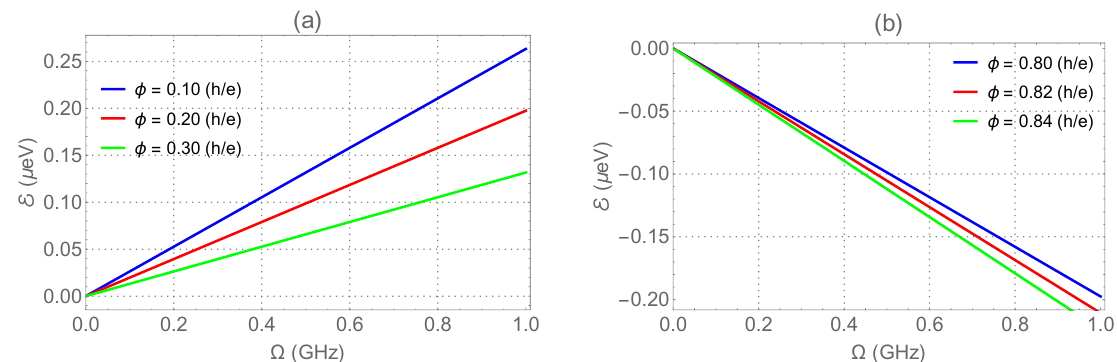
Figure 2. Energy as a function of Ω for two different ranges of φ with m = 0 and R = 5 nm. For values of φ smaller than 0.5 the energies are positive (panel ( a )) while for larger values they are negative (panel ( b )).